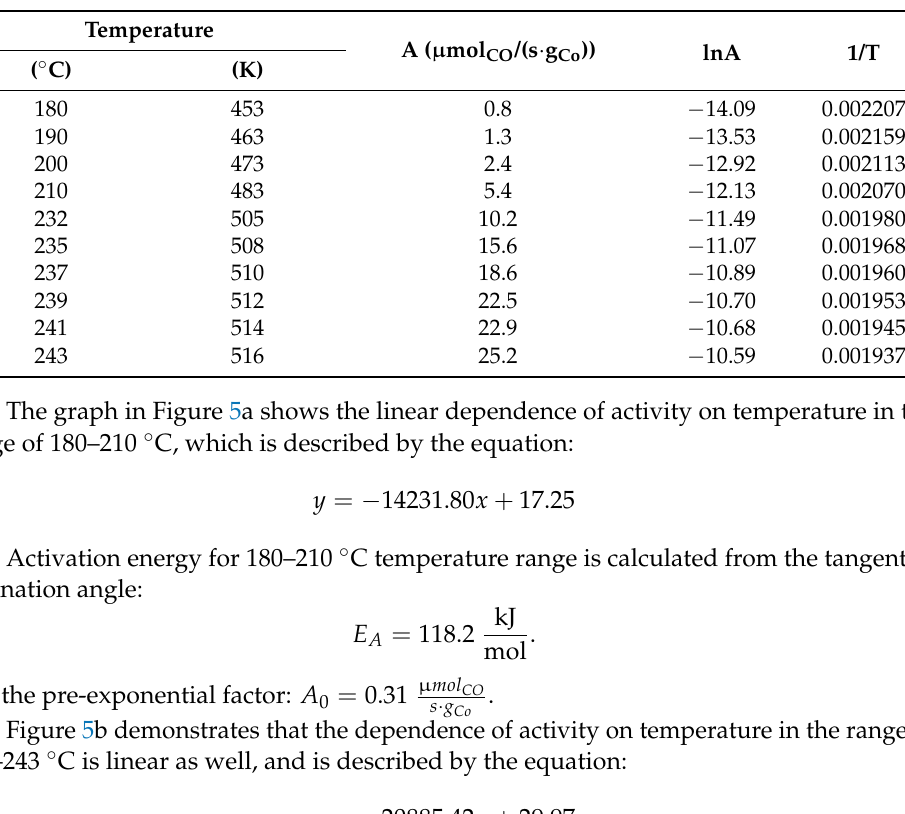
Figure 4. Graph of catalyst B activity versus synthesis gas velocity at 243 °C and 2 MPa.